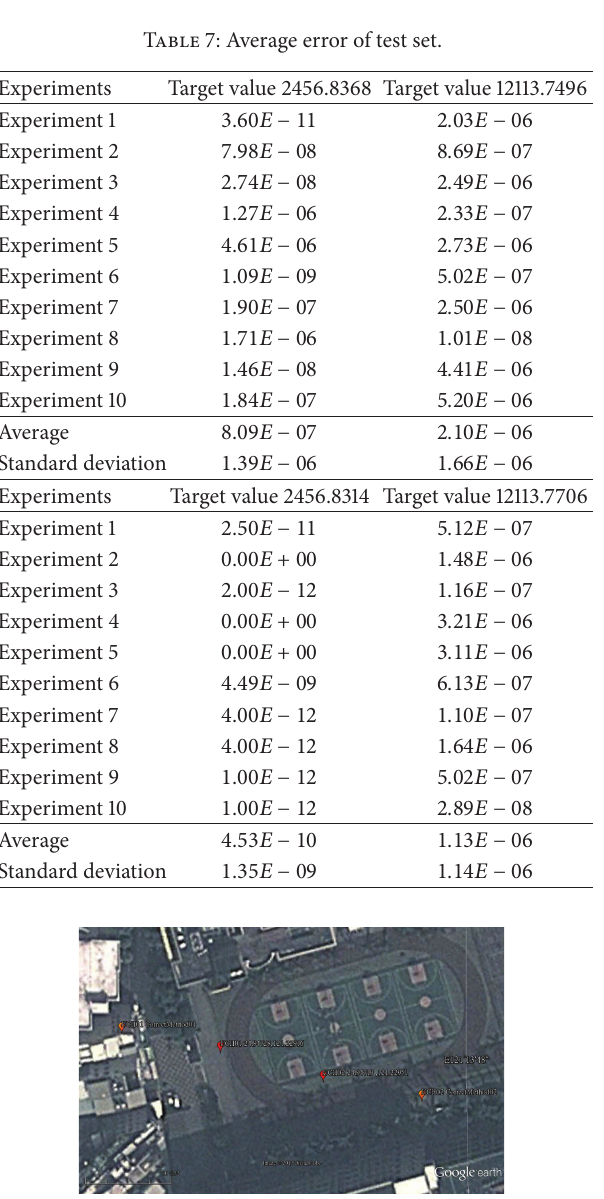
Figure 6: The image of UCH01, UCH02 and the corrected positions using simple correction method (image from Google with a propor- tional scale of 30 m).